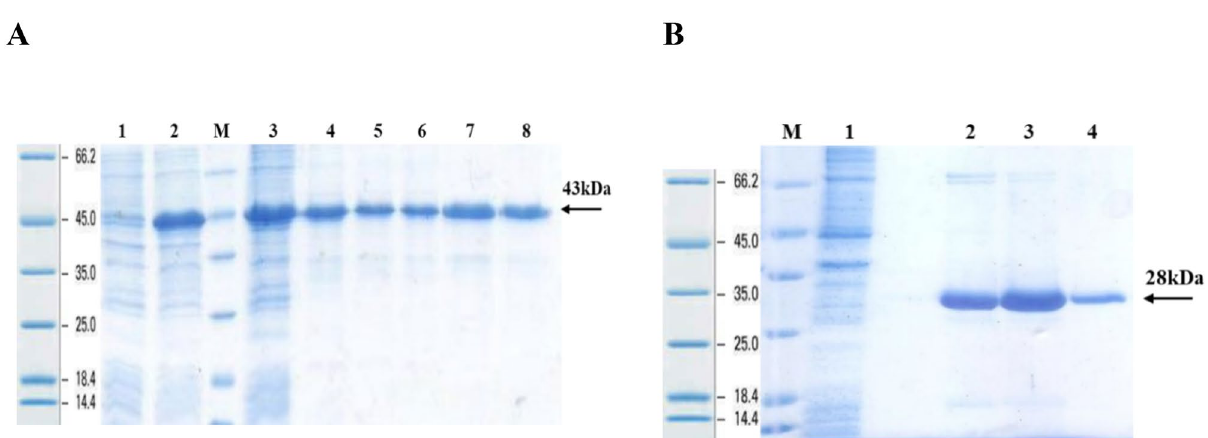
Figure 6. Protein purification: ( A) YFL001: #1, 2: Recombinant E. coli lysate (BI and AI); M: Protein Mw marker (Fermentas); #3: Initial sample; #4–8: Eluted protein samples; ( B) YFL002: M: Protein Mw marker (Fermentas); #1: Flow through sample; 2–4: Eluted protein samples. The full size original gels and the blot are presented in Supplementary Figs. S4 and S5,